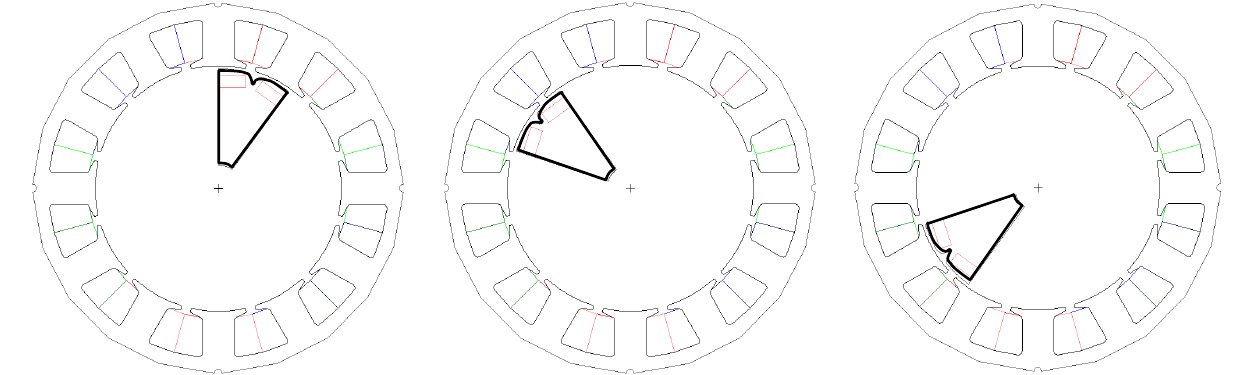
Figure 4. The HMPP in different mechanical angle positions and cogging torque waveforms: ( a ) 0 degree; ( b ) 72 degrees; and ( c ) 144